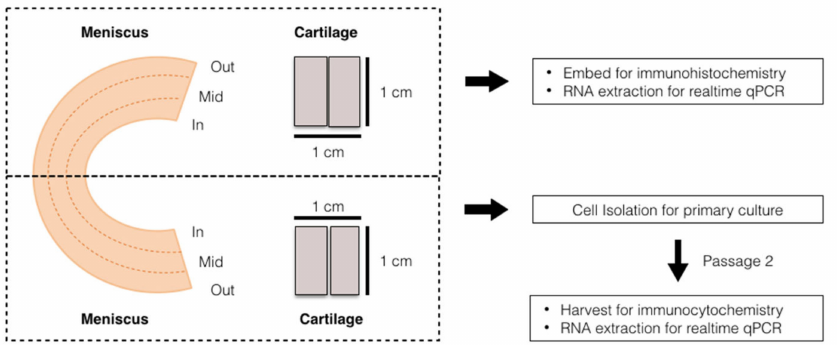
Figure 2. Diagram of the sample preparation. The prepared meniscus and cartilage tissues from individual patients were equally separated into two portions: the first portion was used for histology and native cell RNA extraction, and the other portion was used for cell isolation, then cultured into passage 2 before we proceeded with the other